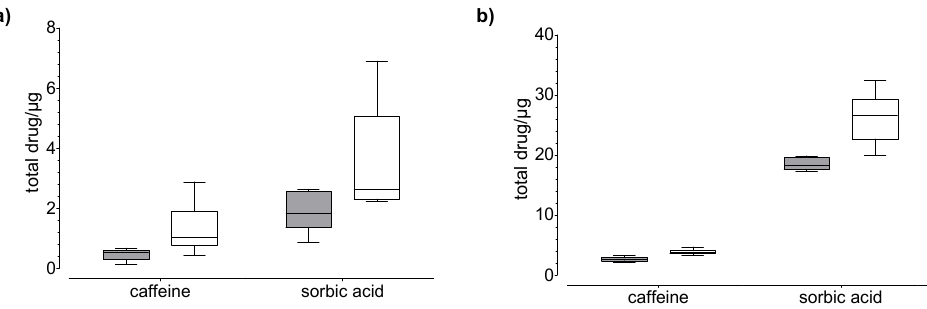
Figure 4. Results of the drug ( a ) permeation through and ( b ) penetration into nail (grey) and hoof (white) membrane after 24 h of exposure to caffeine and sorbic acid (donor: 100 µg). Box plot with median, minimum, maximum, and the 0.25 and 0.75 quartiles, n = 6.